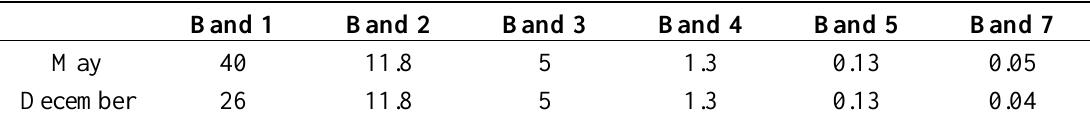
Table 1. Computed haze ( L ) values for each band using the Dark Object h